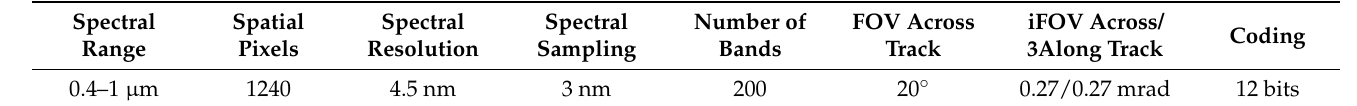
Figure 1. Study site of Porspoder (Brittany, France: 48°28.88′ N/4°46.29′ W) showing the 24 in situ sampling spots surveyed during the study. The color of the circles indicates the intertidal level con- sidered: red circles, P. canaliculata — F. spiralis ; yellow circles, A. nodosum ; black circles, F. serratus ; blue circles, H. elongata . The dotted lines correspond to the UAV flight lines.